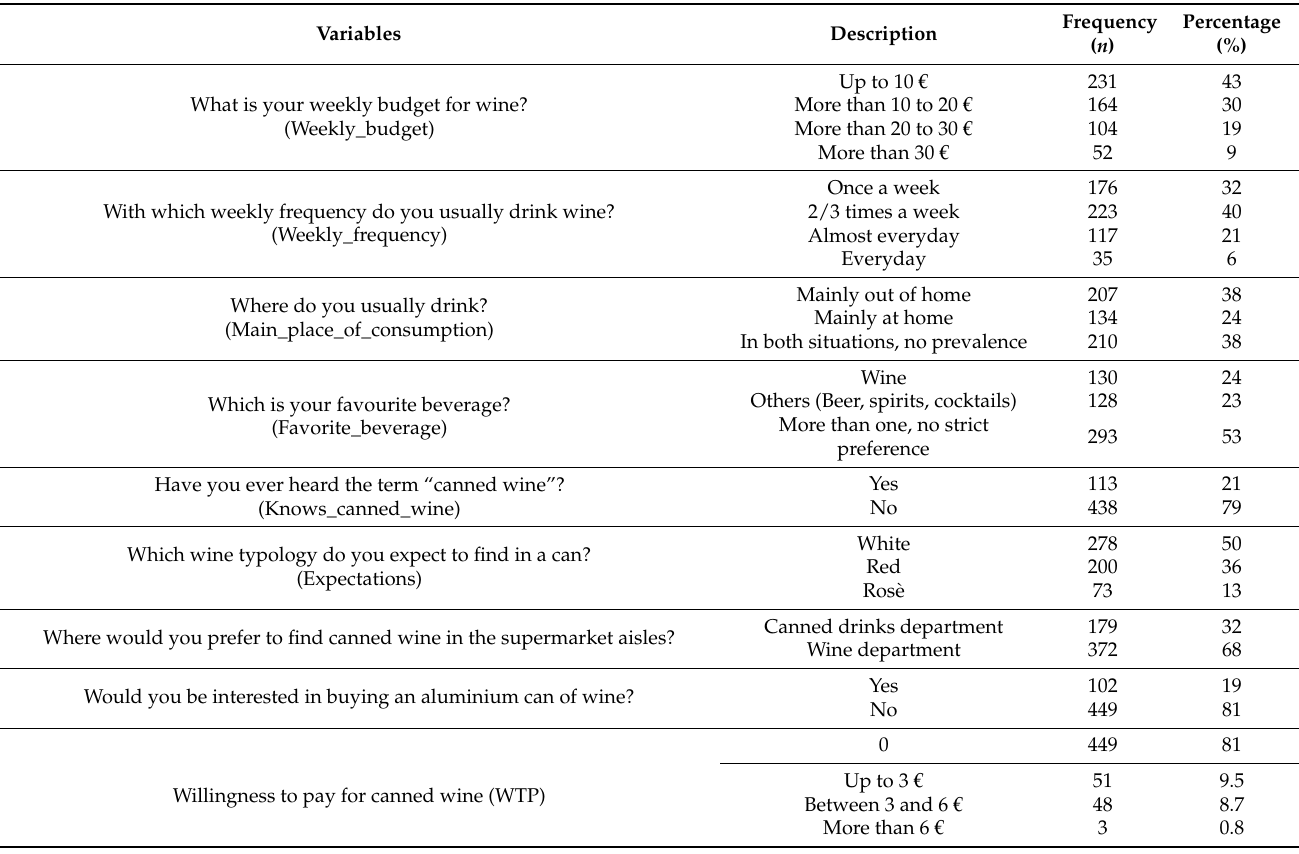
Table 2. Habits and attitudes of wine consumption of the sample, absolute numbers, and relative